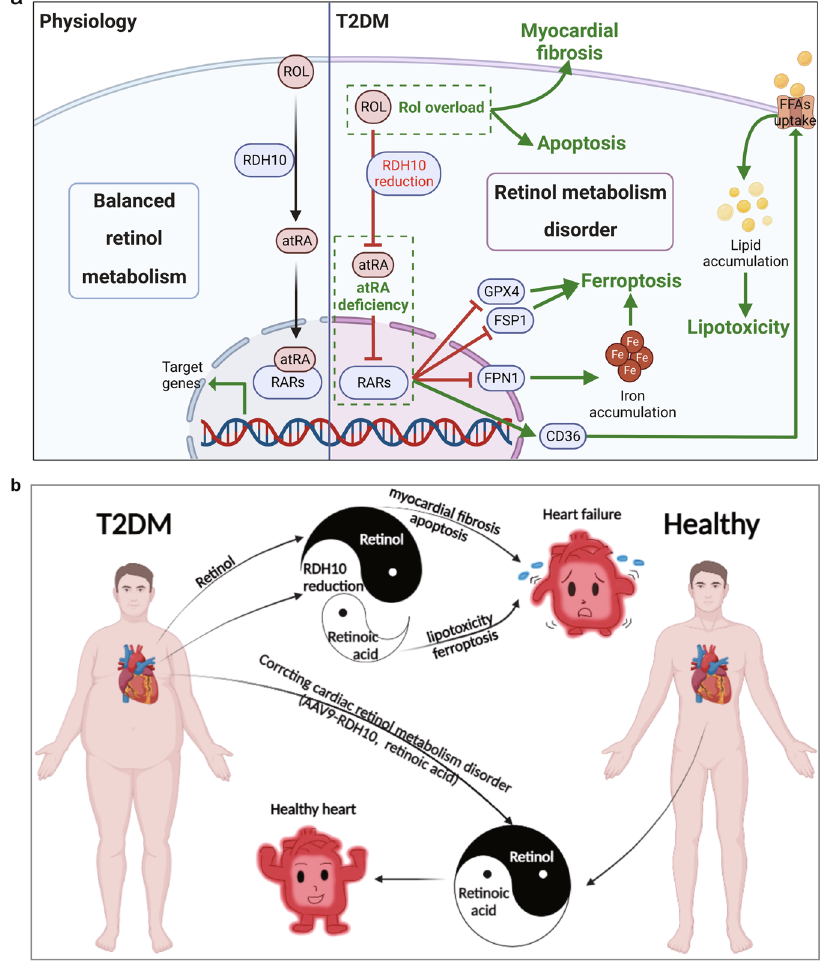
Fig.9|Graphicalabstract.a Graphicalsummaryofthemechanisticstudyofthisstudy. b Graphicalsummaryofclinicalimplicationsofthisstudy.Graphicswerecreated with